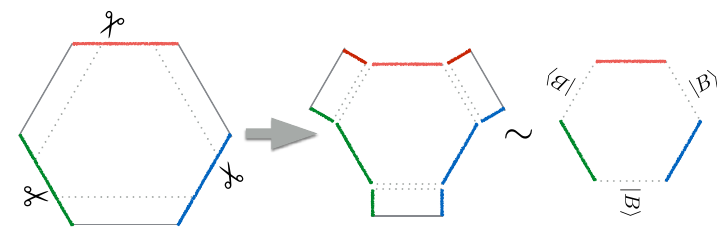
Figure 2 . Three-point function of the open strings (open